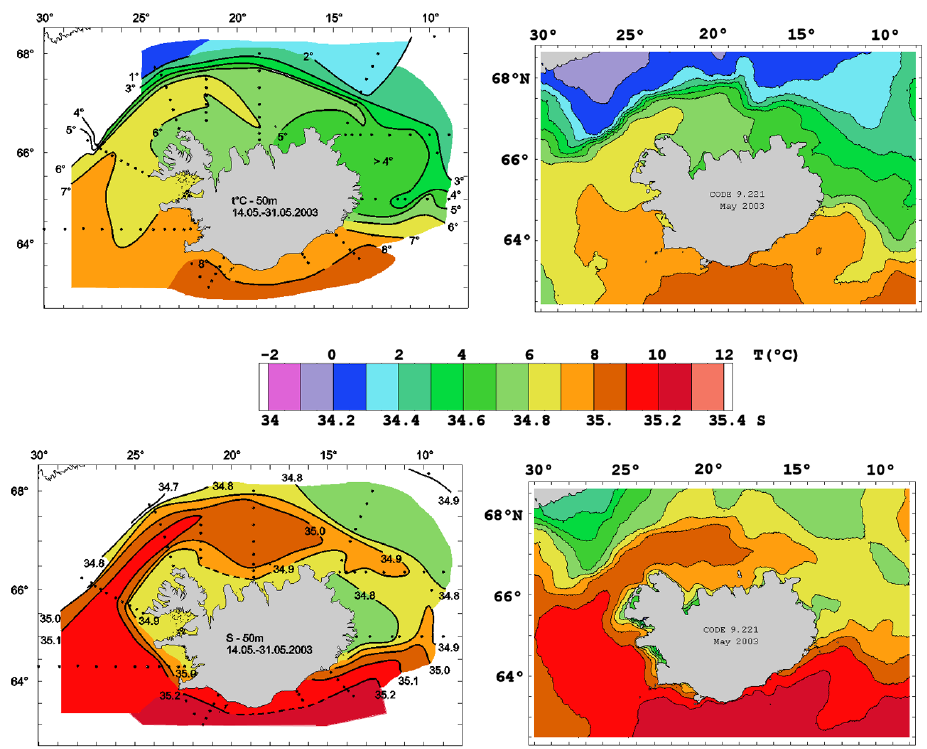
Fig. 4. Observed (left panels) and simulated (right panels) temperature (upper row) and salinity (lower row) in May 2003 at the depth of 50m. Observational based charts are drawn after charts published by the Marine Research Institute, Iceland (www.hafro.is/Sjora/). The black dots show the location of CTD stations.